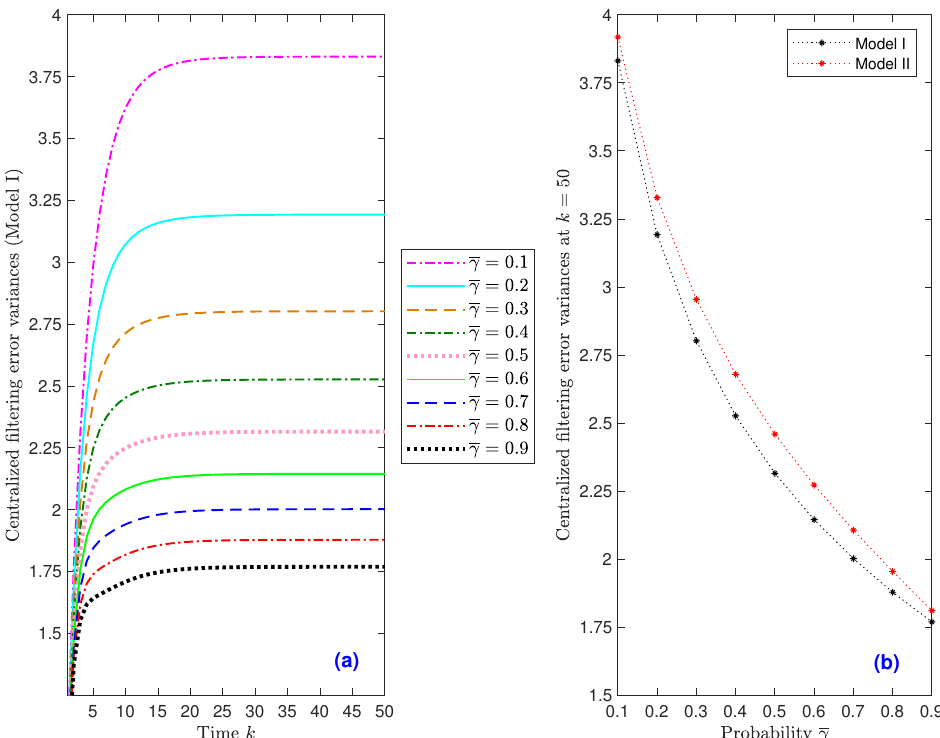
Figure 5. Centralized fusion filtering error variances: ( a ) under Model I when γ = 0.1 to 0.9; ( b ) under Model I and Model II at k = 50, versus γ